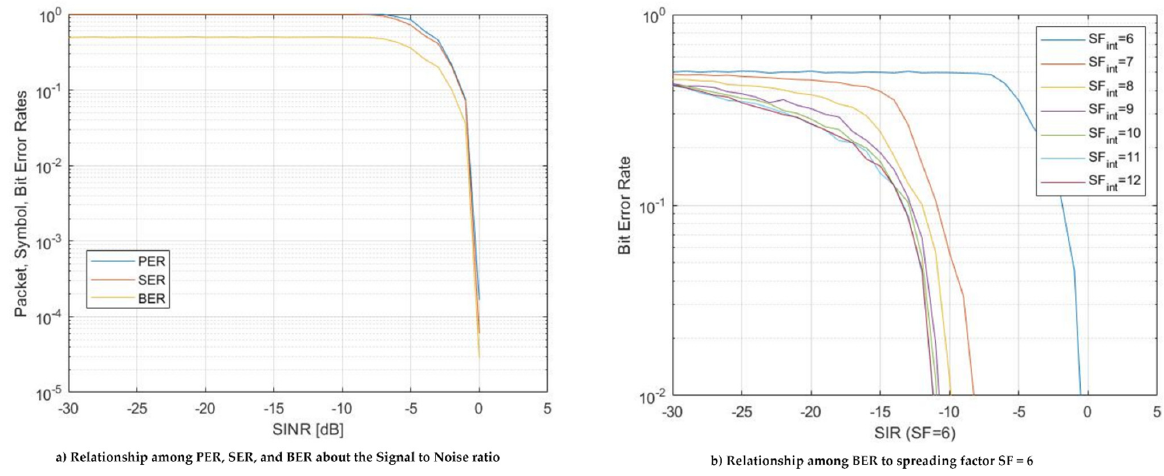
Figure 14. ( a , b ) PER, SER, and BER versus the signal to noise ratio and BER versus SF = 6.